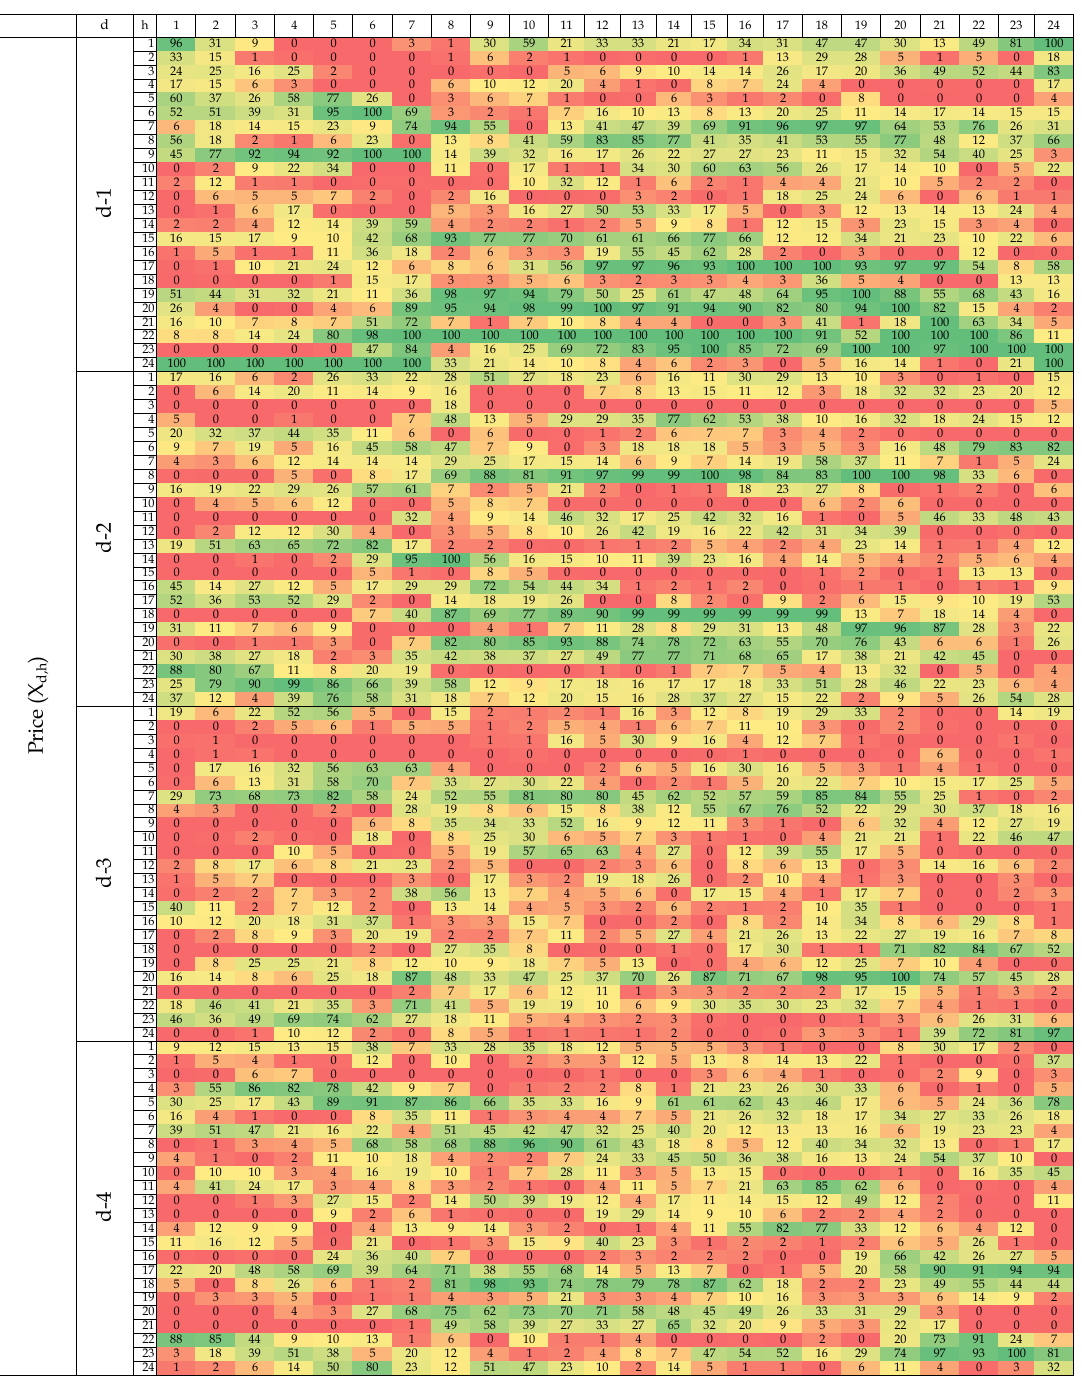
Table 3. Mean occurrence (in %) of model parameters across the 631-day test period. The columns represent the hours and the rows represent the parameters of the 1xN Lasso 182 N-PIT -transformed Nord Pool data. A heat map is used to indicate more ( → green) and less ( → red) commonly-selected